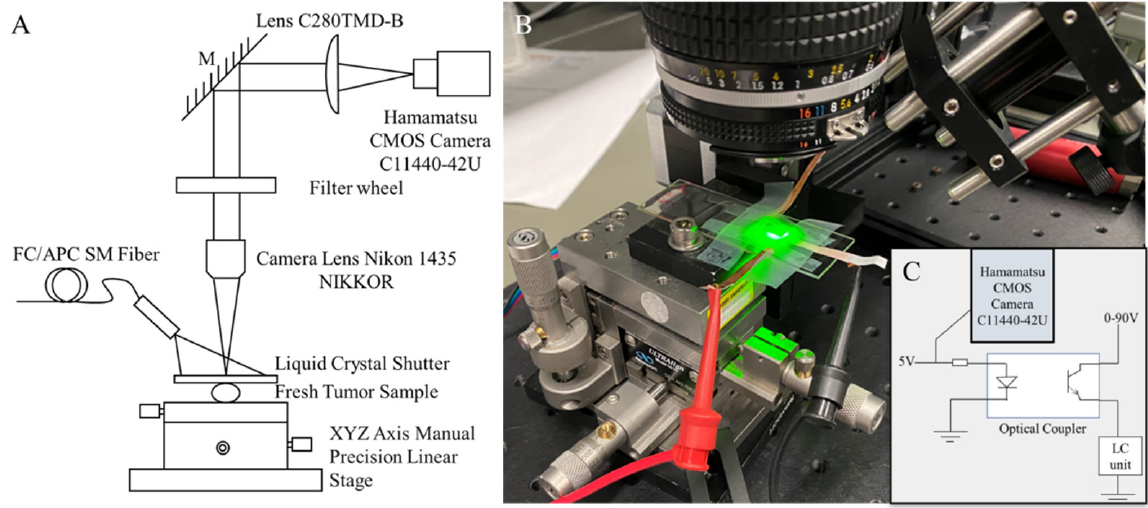
Figure 2. ( A ). Schematic of the WFM setup. ( B ). An image of the actual experimental setup. ( C ). Schematic diagram of the control circuit.